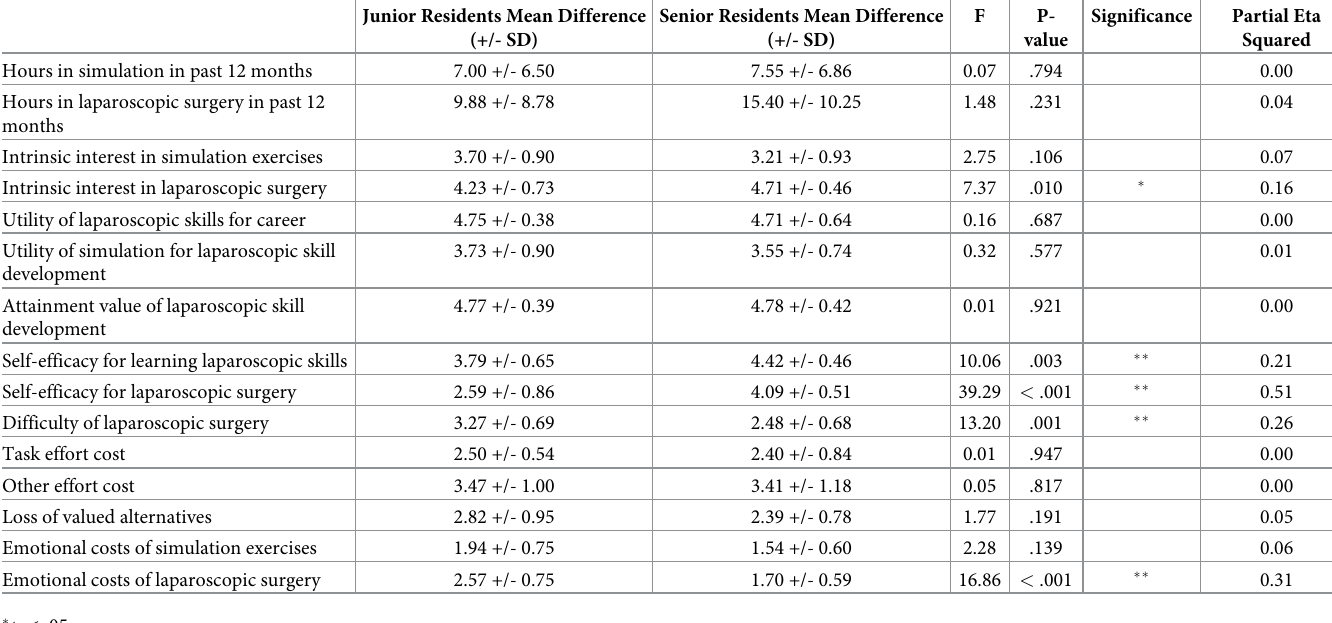
Table 3. Differences between junior and senior residents in motivations for and experience with laparoscopic simulation and minimally invasive surgery. Junior Residents Mean Difference (+/-